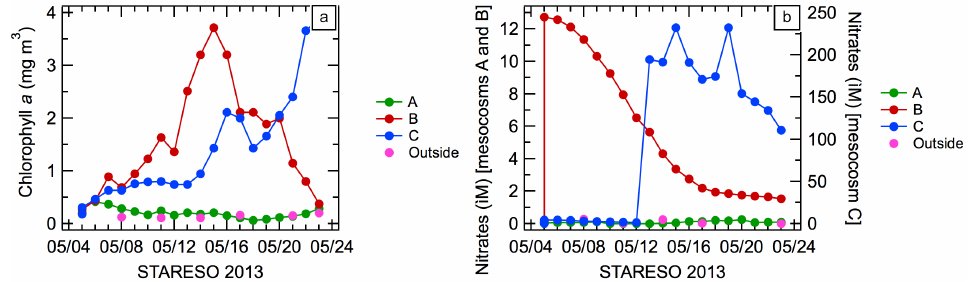
Figure 1. Temporal trends of (a) chlorophyll a concentrations measured by fluorometer and (b) nitrate concentrations measured by Technicon autoanalyser over the time course of the experiment. Panel (b) clearly shows the enrichment of mesocosm B the first day of the campaign and the enrichment of mesocosm C on 12 May, compared to the control mesocosm